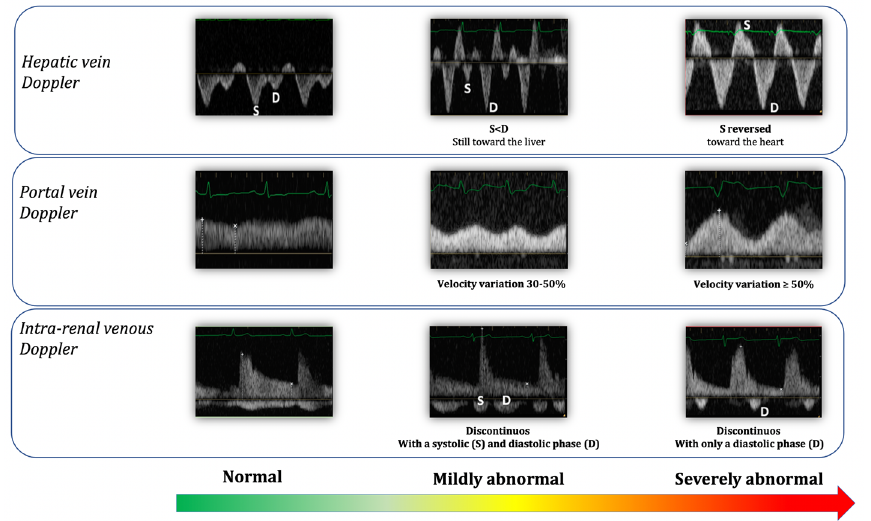
Figure 5. Normal findings and different grades of abnormal findings in venous ultrasound evaluation. Adapted from [39].